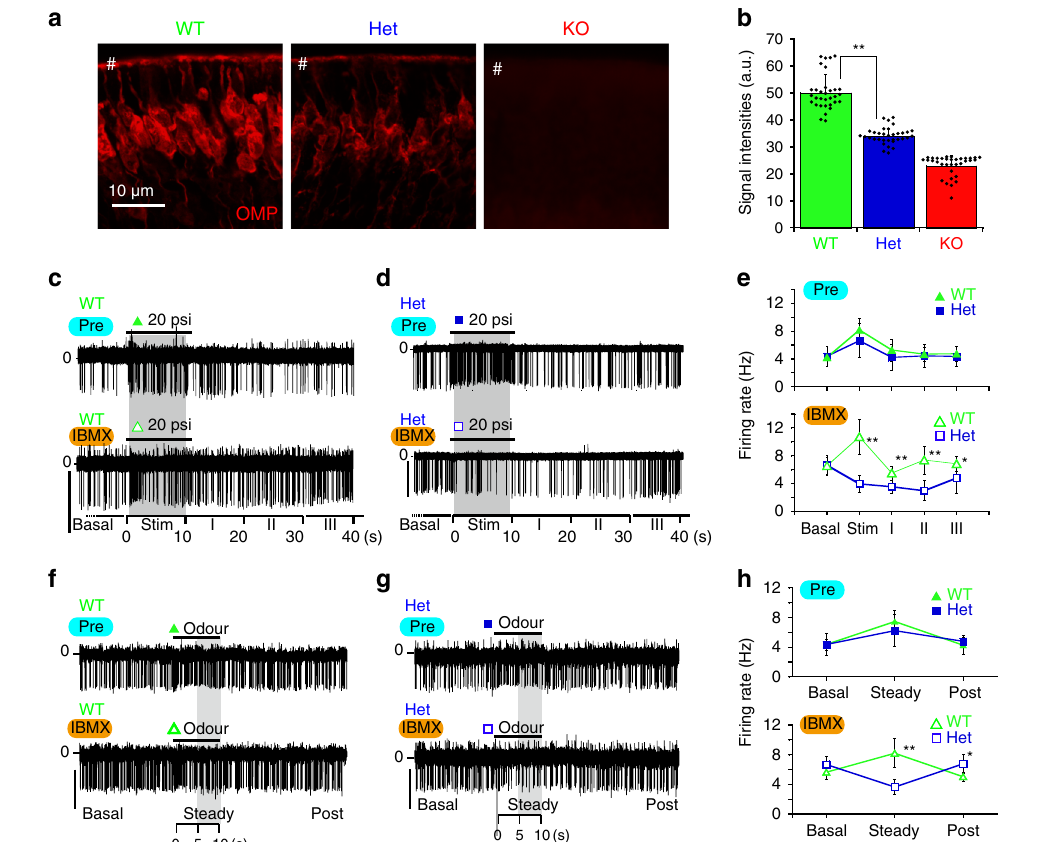
Fig. 6 OMP confers tolerance to cAMP overload. a OMP immunoreactivity in WT, Het and KO neurons. # indicates apical dendritic regions of ORNs. b OMP-immunoreactive signal intensities were measured at # in ( a ). a.u. arbitrary unit. Signals of KO neurons were used to set a nonspeci fi c